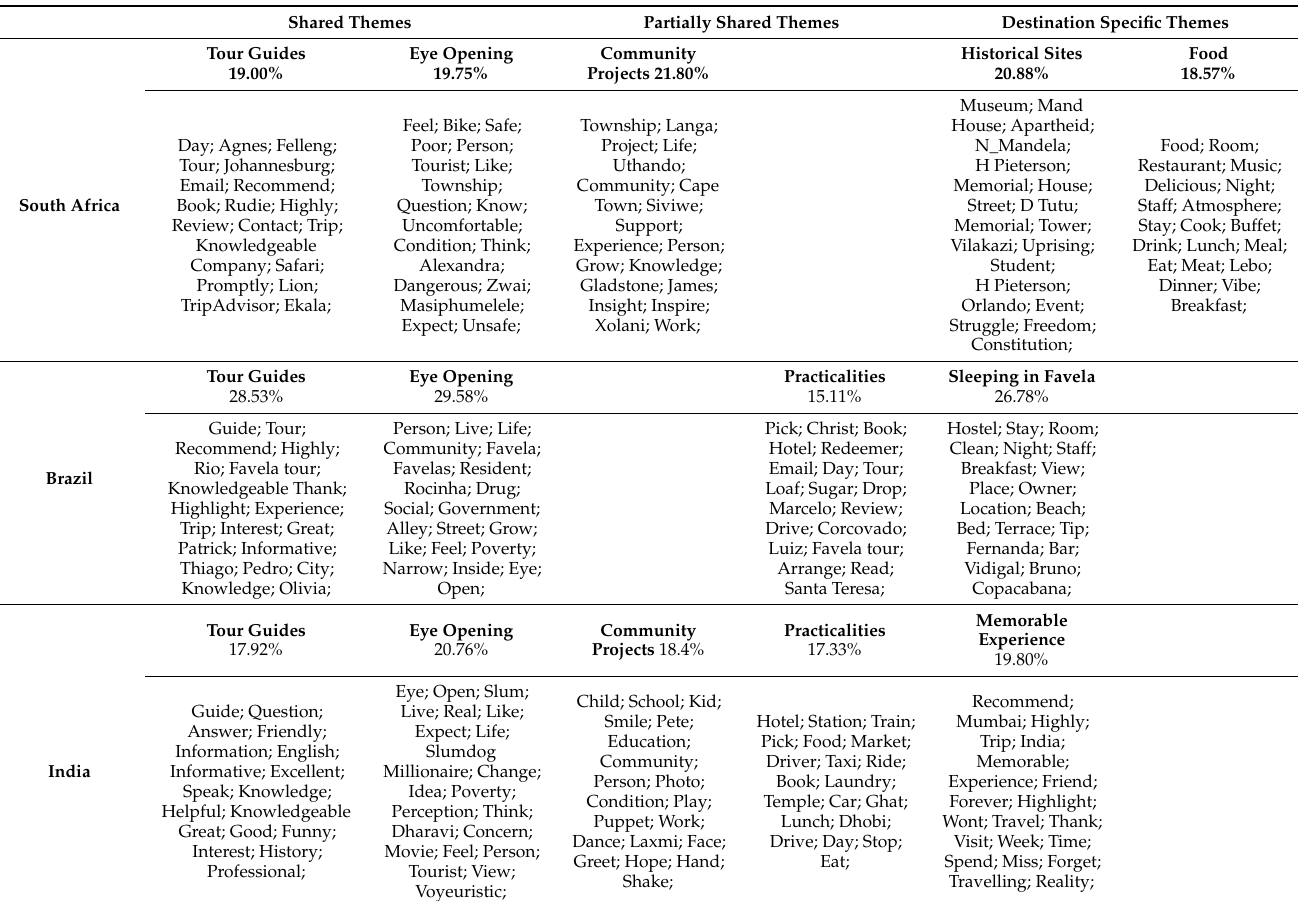
Table 3. Shared and specific themes emerging from descending hierarchical